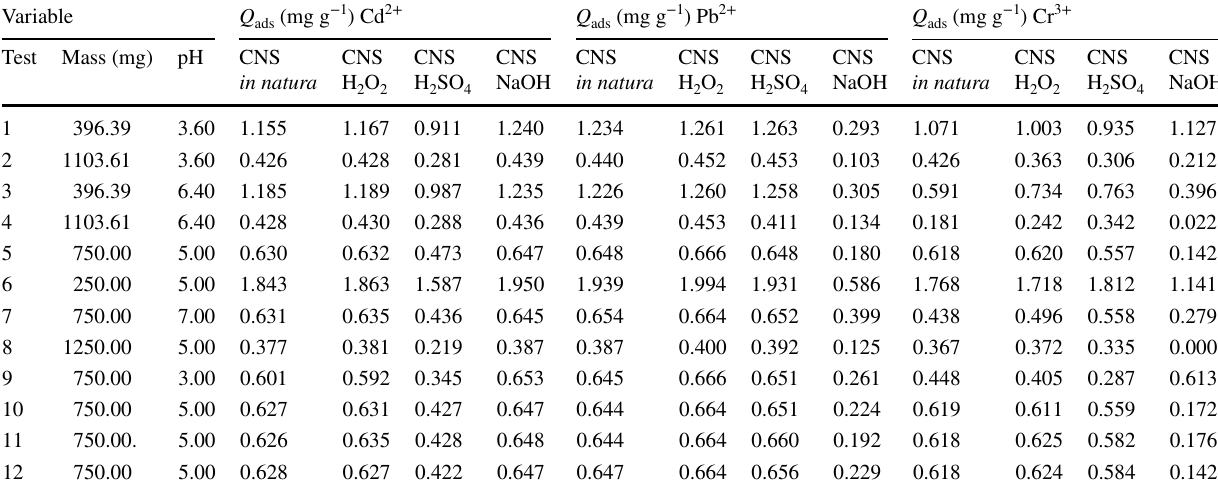
Table 4 CCRD planning matrix with triplicate in central point in their coded values and real values for absorption of Cd 2+ , Pb 2+ and Cr 3+ by adsorbents in natura and modified with H 2 O 2 , H 2 SO 4 and NaOH